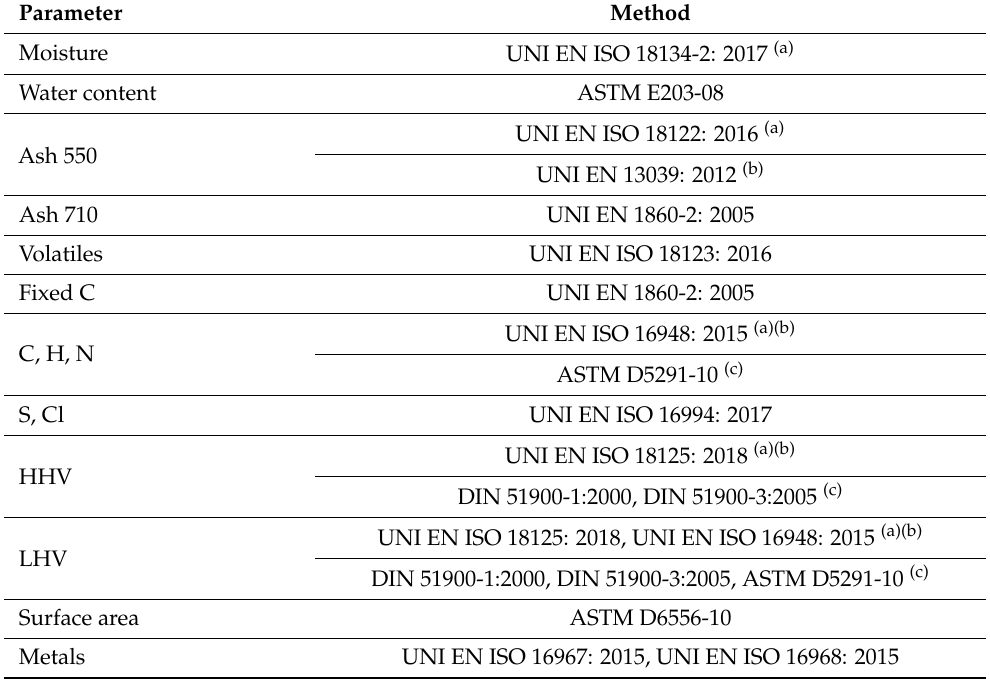
Table 1. Analytical methods adopted for material characterisation.